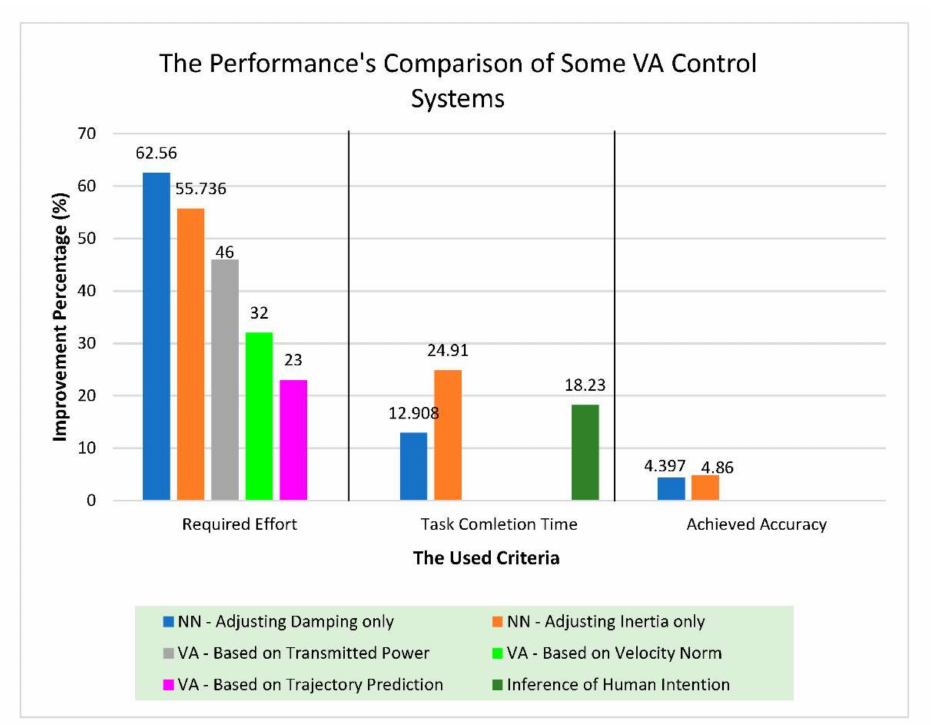
Figure 7. The performance’s comparison between some developed VA control systems. The main criteria used are the required human effort, needed task time, and the obtained